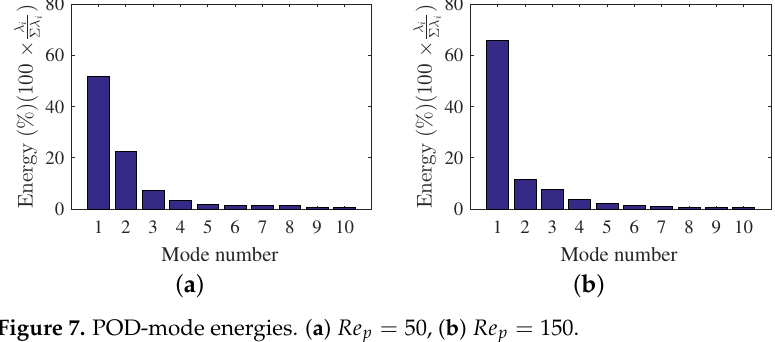
Figure 7. POD-mode energies. ( a ) Re p = 50, ( b ) Re p = 150.